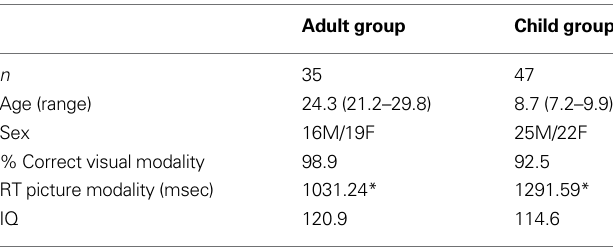
Table 2 | Group characteristics of unaffected adults and